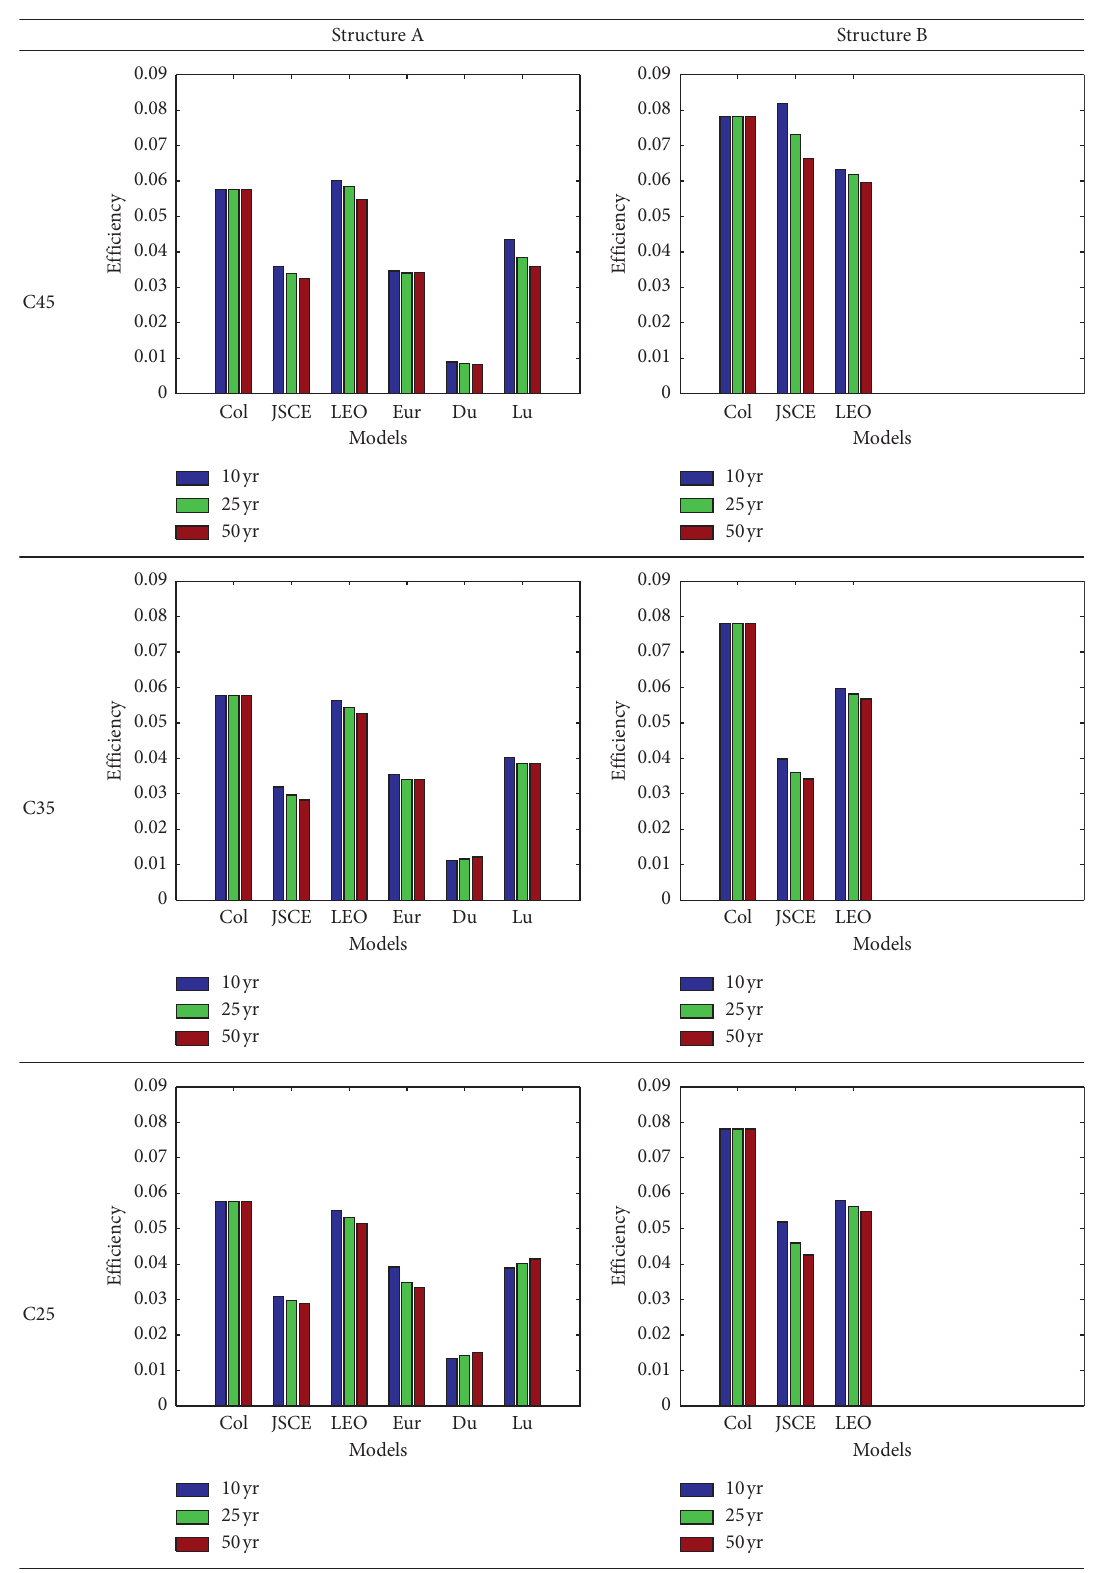
Figure 6: Efficiency of each chloride ingress model according to each hypothesis for structure A and structure